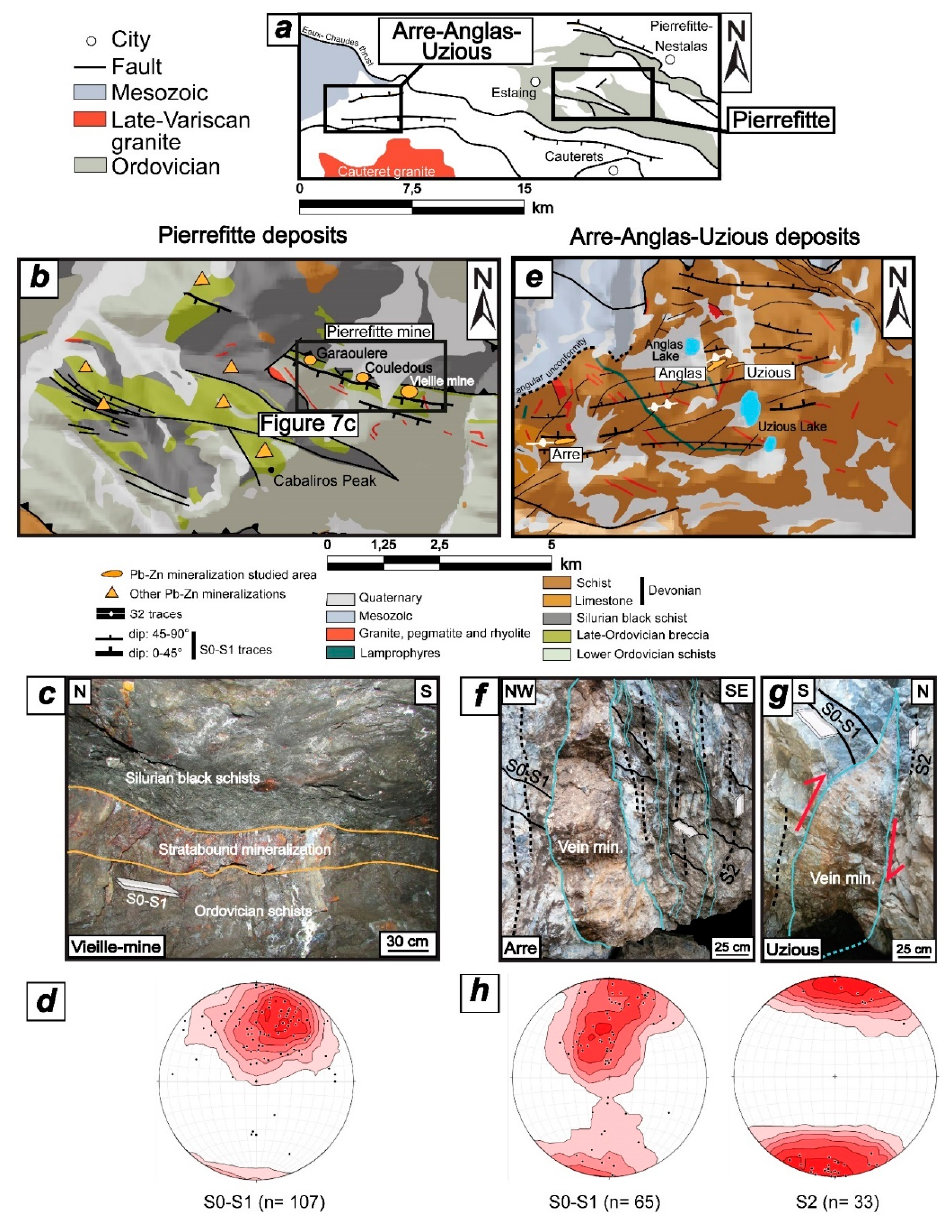
Figure 7. The Pierrefitte anticlinorium. ( a ) Simplified structural map showing the location of ( b , e ); ( b ) structural map zoomed on Pierrefitte mine (Lithologies are based on BRGM geological maps [59]; ( c ) photograph of typical stratabound Pb-Zn mineralization in Pierrefitte mine; ( d ) Schmidt stereographic projections (lower hemisphere) of poles to S 0 -S 1 foliations measured in the Pierrefitte anticlinorium; ( e ) structural map of the Pierrefitte-Valentin anticlinorium zoomed on Anglas-Uzious and Arre mines (Lithologies are based on BRGM geological maps); ( f ) photograph of Arre vein mineralization parallel to S 2 cleavage; ( g ) photograph of Anglas-Uzious vein mineralization; and ( h ) Schmidt stereographic projections (lower hemisphere) of poles to S 0 -S 1 and S 2 foliations measured in Anglas-Uzious and Arre